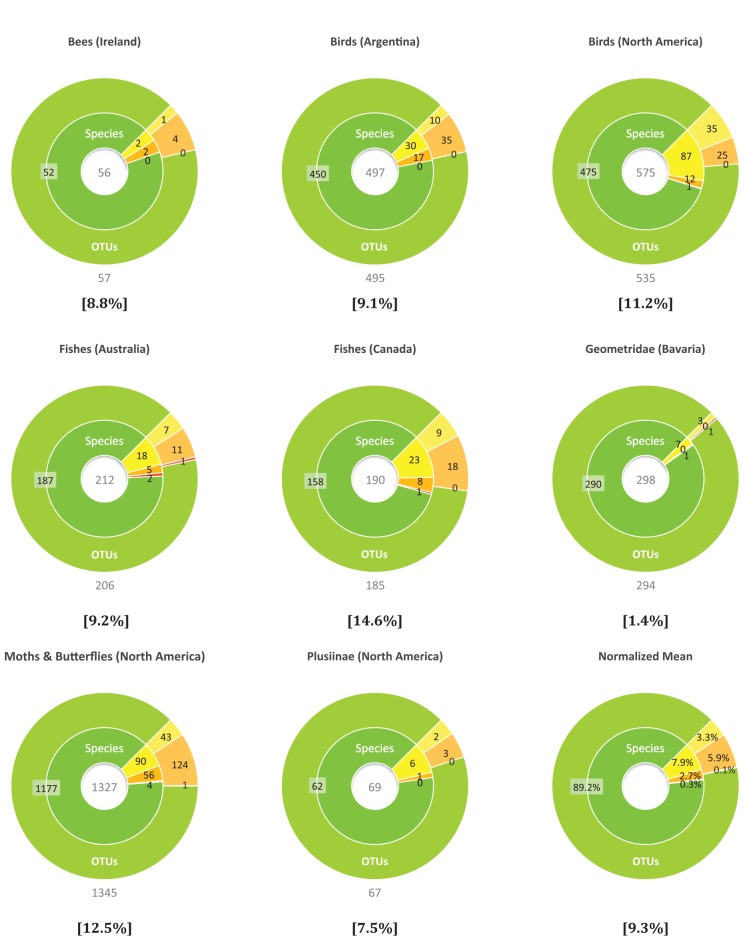
Comparison of BIN and species boundaries in eight datasets.Each inner ring partitions species, based on their assignment to BINs as MATCHES (green), MERGES (yellow), SPLITS (orange) or MIXTURES (red). Each outer ring categorizes BINs into those that MATCHED species, MERGED species, SPLIT species or MIXTURES using the same colour scheme. The number below each chart is the OTU count while the percentage indicates the incidence of OTUs that were not MATCHES.